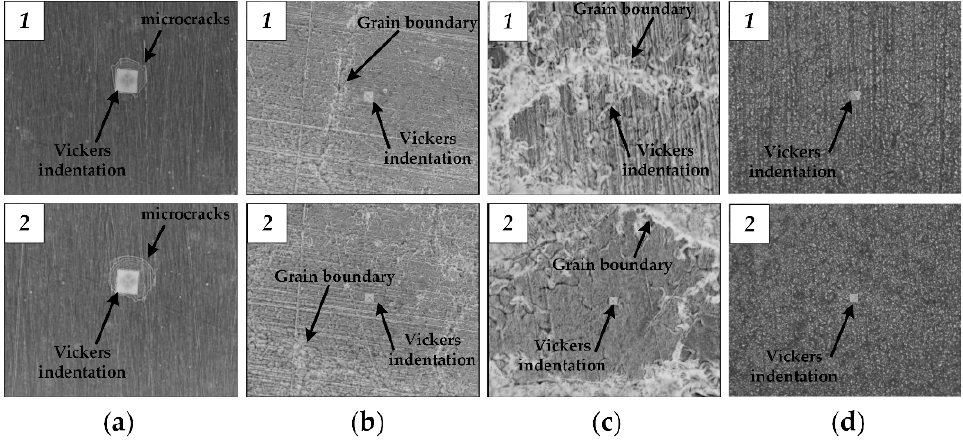
Figure 11. Imprint of Vickers pyramid on surface of titanium Grade 2 in initial state ( a ), after nitriding at 750 ◦ C ( b ) and 900 ◦ C ( c ), and after boriding ( d ): 1 and 2—nanoindentation near grain boundary and in grain body, respectively.